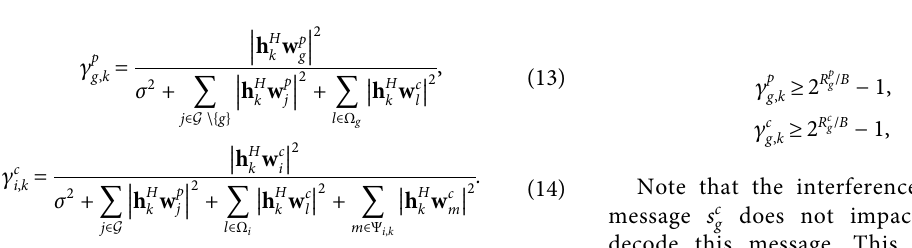
Frontiers in Communications and Networks |